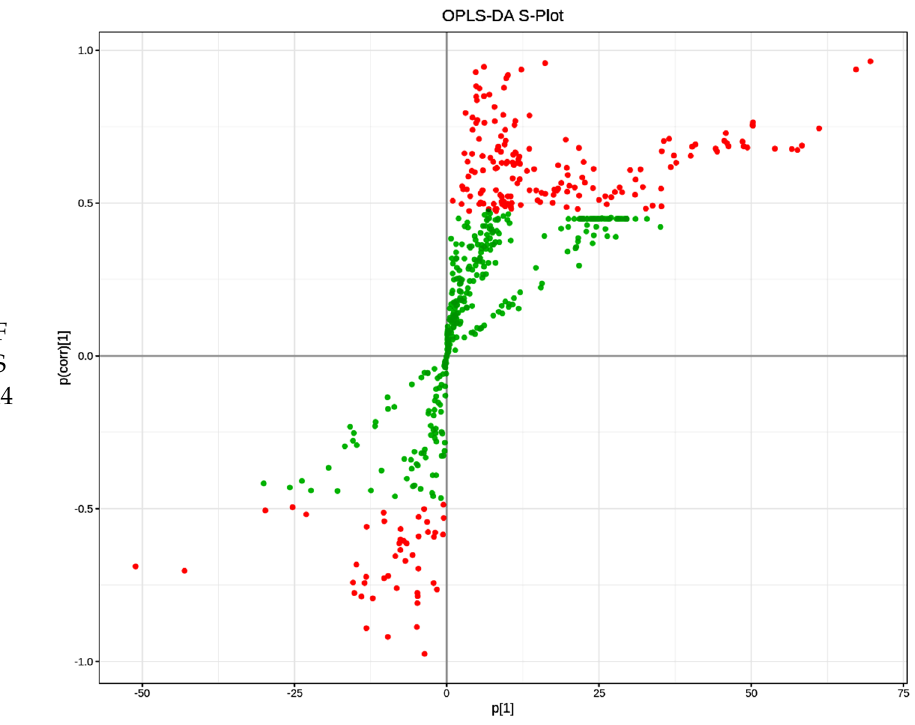
Figure 2. The abscissa indicates the co-correlation coefficient between the principal components and metabolites, the ordinate indicates the correlation coefficient between the principal components and metabolites, the closer to the upper right corner and the lower left corner of the metabolite indicates that the difference is more significant, the red dot indicates that the VIP value of these metabolites is greater than or equal to 1, and the green dot indicates that the VIP value of these metabolites is less than 1.